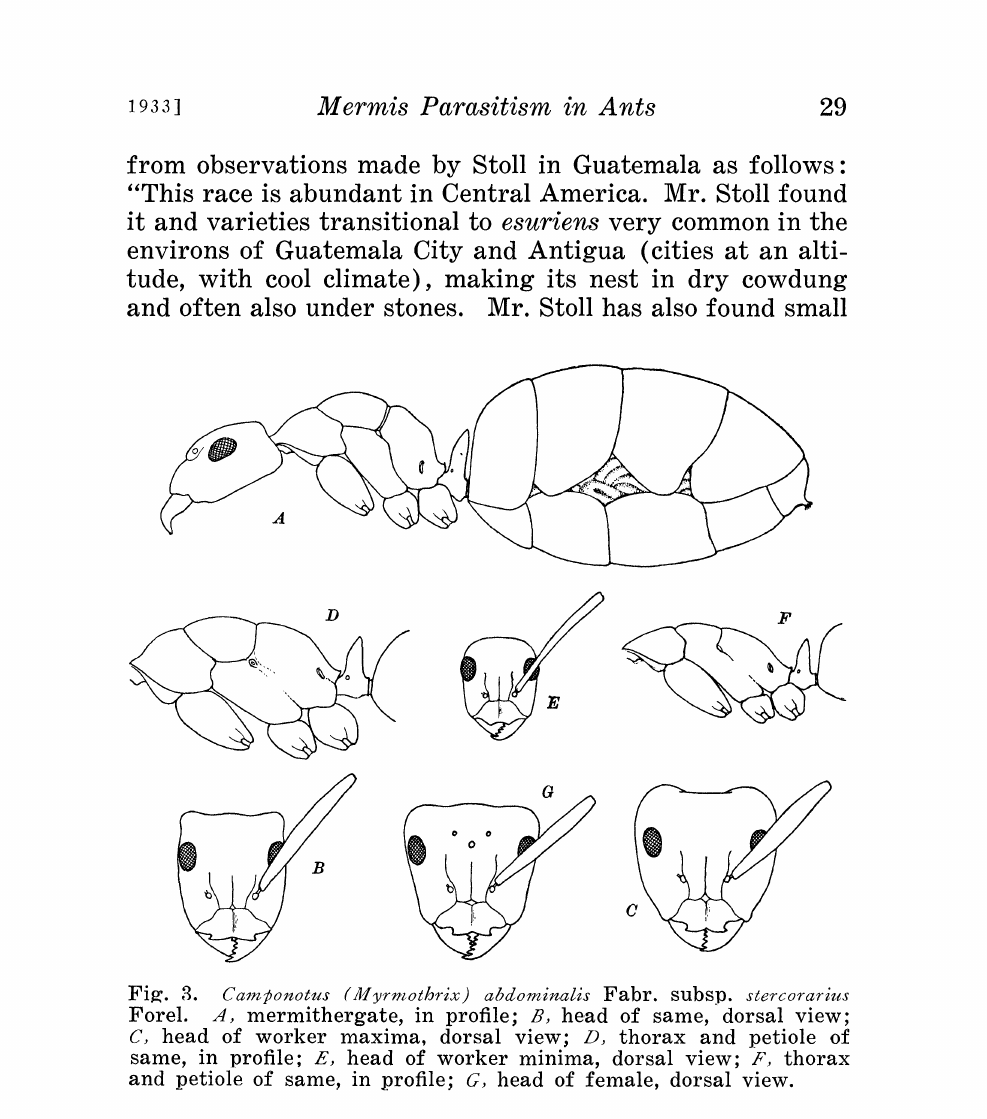
Fig. 3. Canponots (Myrmotbrix) abdoninalis Fabr. subsp, stercorarits Forel. A, mermithergate, in profile; B, head of same, dorsal view; C, head of worker maxima, dorsal view; D, thorax and petiole of same, in profile" ’, head of worker minima, dorsal view; F, thorax and petiole of same, in profile; G, head of female, dorsal